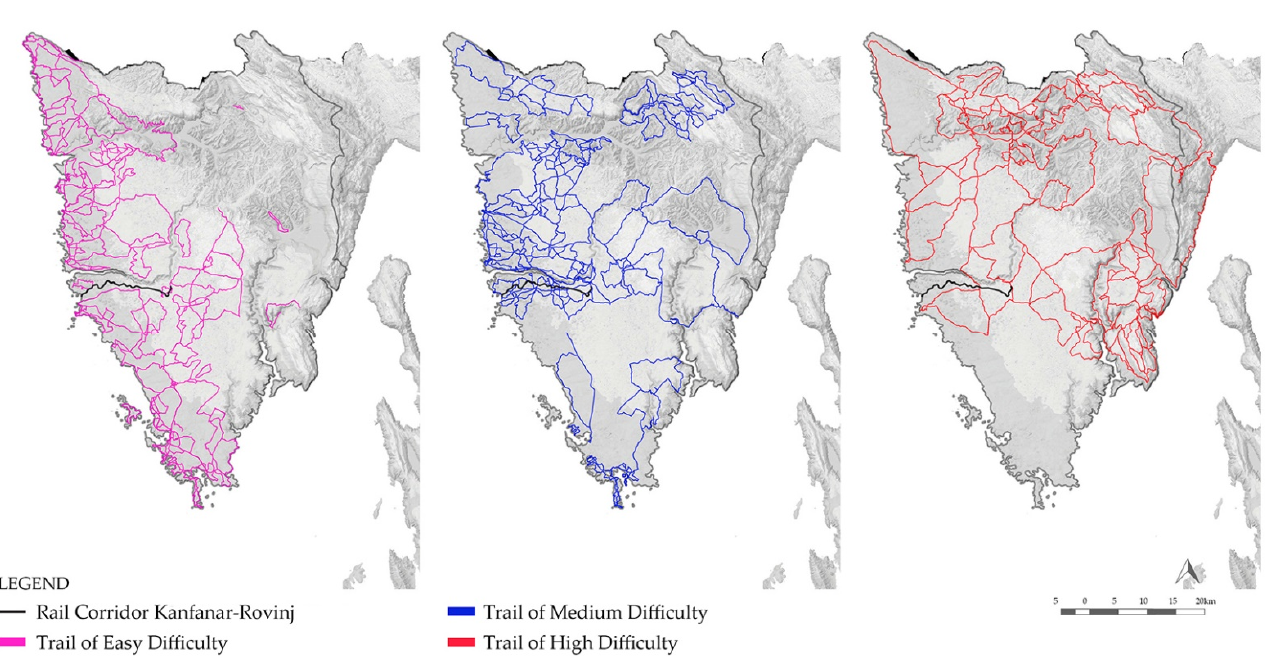
Figure 3. Existing bicycle trails in Istria County.